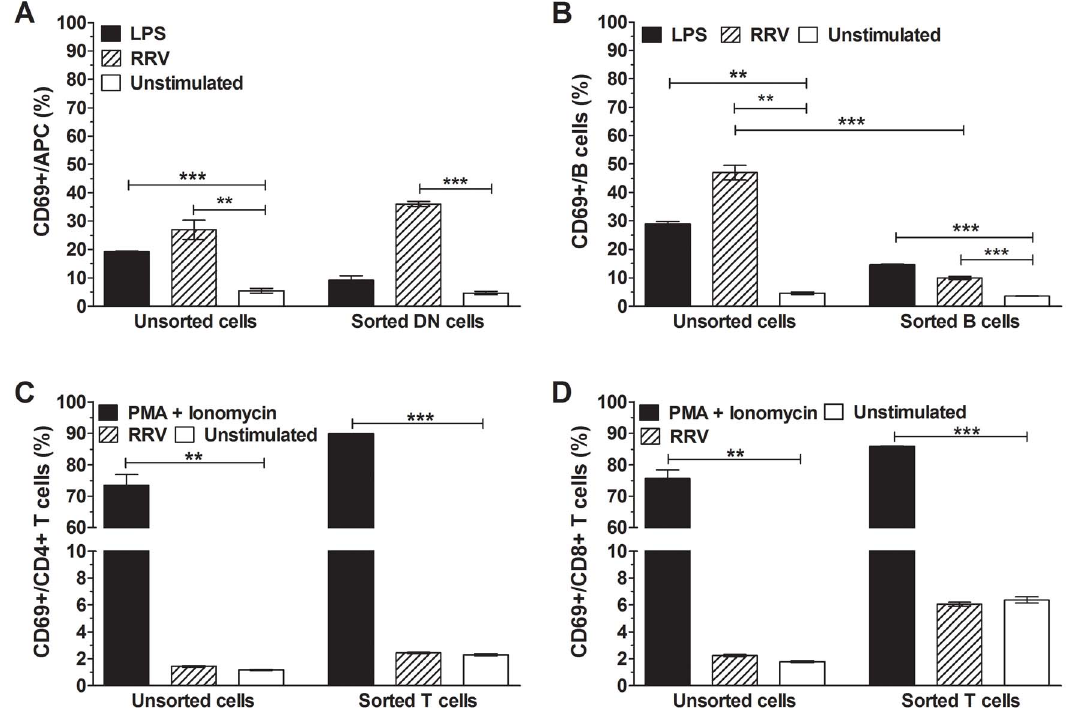
Figure 6. Activation of APCs, B cells, CD4 + T cells and CD8 + T cells by RRV. Sorted DN (CD3 2 CD19 2 ) cells, B cells and T cells were stimulated with 100 ng/ml RRV for 24 h. The proportion of activated (CD69 + ) cells within each sorted population was determined and compared with that in unsorted cells. (A) APCs within the sorted DN population, (B) B cells within the sorted B cell population and (C) CD4 + and (D) CD8 + T cells within the sorted T cell population are shown. Control cells were stimulated with 100 ng/ml LPS (A, B) or 50 ng/ml PMA and 500 ng/ml Ionomycin C (C, D), or left unstimulated. The proportion of activated cells in unsorted splenocytes also is indicated for each cell type. Data are derived from one experiment and are representative of two independent experiments. Error bars indicate the mean 6 SEM of 3 replicates. * p , 0.05, ** p , 0.01 and *** p , 0.001 compared with the respective control.